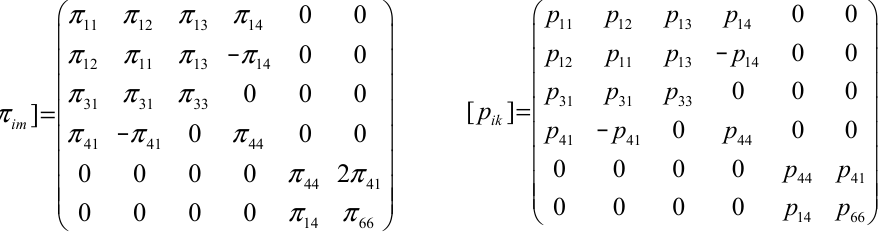
Figure 1. The matrices of piezo- and elasto-optic coefficients of trigonal crystal classes 32, 3 m and 3 m ( π 66 = π 11 − π 12 ; p 66 = ( p 11 − p 12 )/2). Five independent principal piezo-optic coefficients (POCs) π 11 , π 12 , π 13 , π 31 and π 33